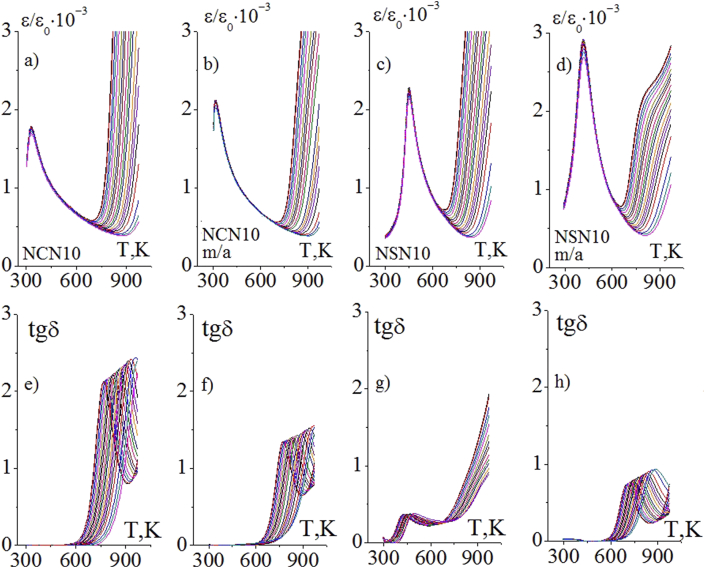
Temperature dependences of ε'/ε0 and tgδ of the non mechanoactivated NCN10 (a, e), mechanoactivated NCN10 (b, f), non mechanoactivated NSN10 (c, g) and mechanoactivated NSN10 (d, h) ceramics obtained at TSin = 1620 K.